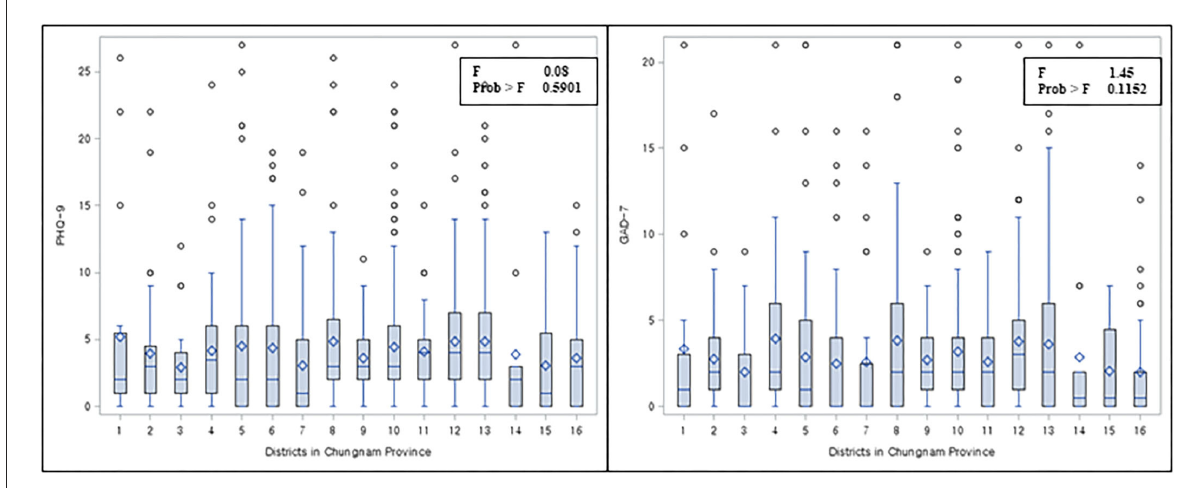
FIGURE1 Distribution of PHQ-9 and GAD-7 by regional-level districts.